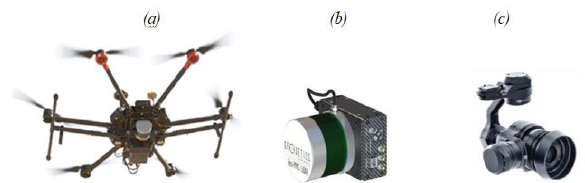
Figure 2 . Equipement: (a) Drone DJI Matrice 600 Pro, (b) LiDAR Geo-MMS, (c) Camera ZENMUSE X5